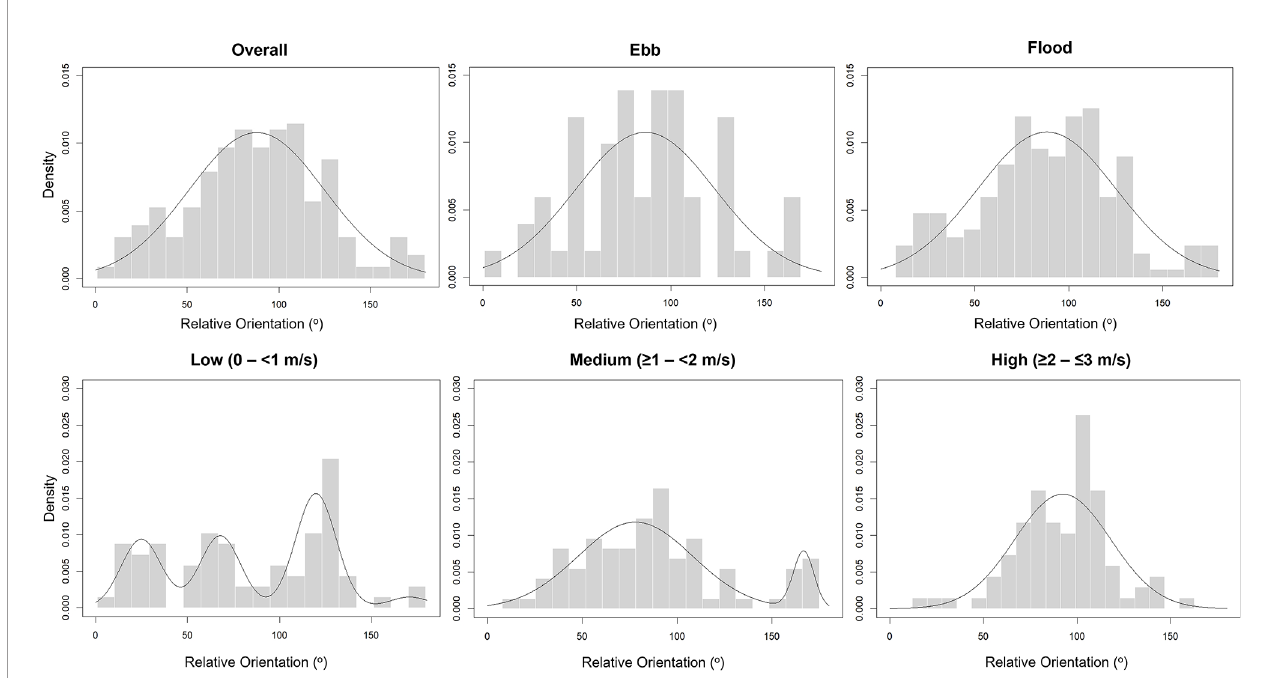
FIGURE 6 | Observed densities of auk orientation relative to fl ow (grey bars) overall, split by ebb and fl ood tidal phase and across differing current velocity ranges, with Gaussian mixture-based density estimate curves (black